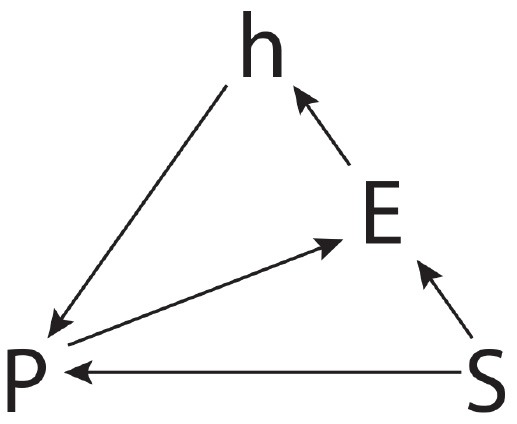
The SHaPE model.